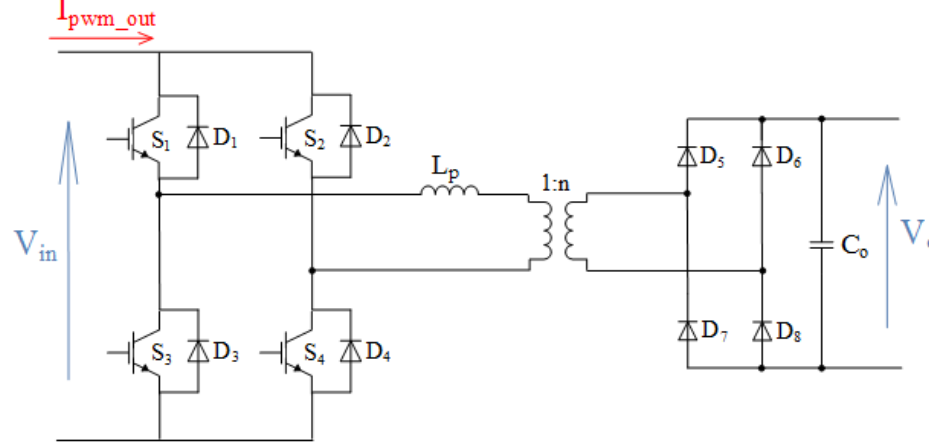
Figure 3. Single active bridge